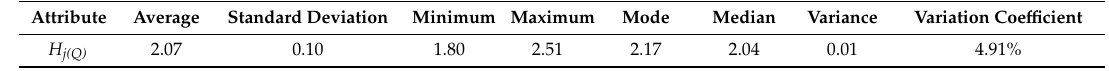
Table A9. Exploratory analysis of groundwater samples. Table B2. Exploratory analysis of groundwater samples.